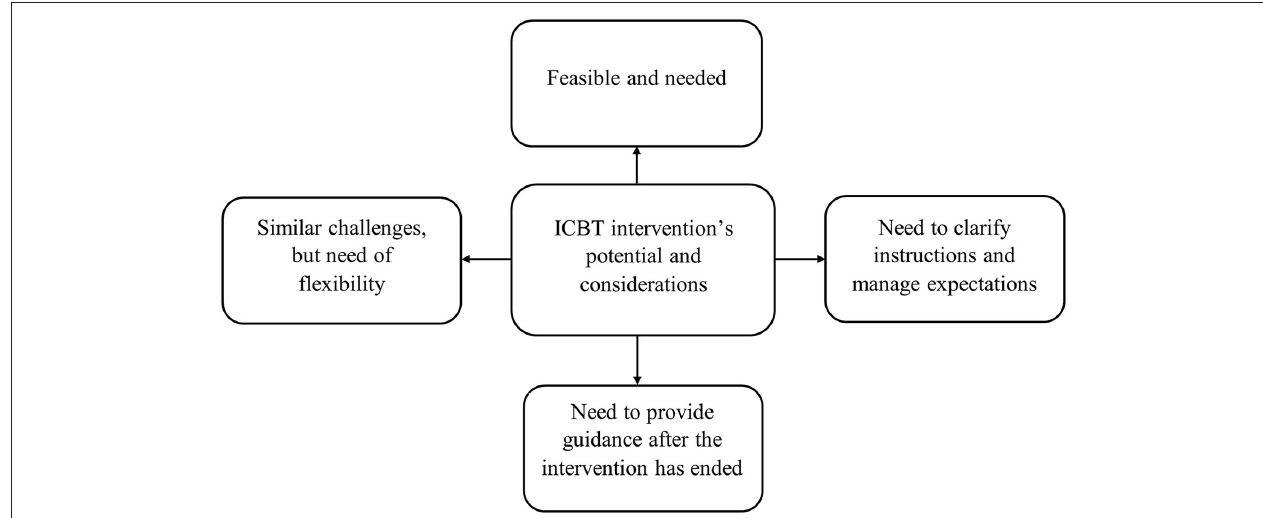
FIGURE 4 | Main theme and sub-themes generated following stakeholder focus group discussion.